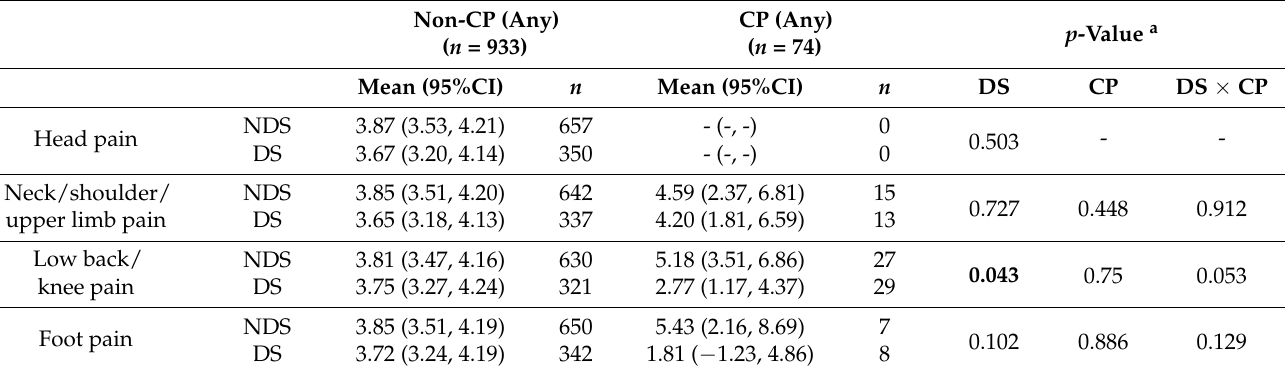
Table 4. Interactions between depressive symptoms and CP on alcohol intake (density method) in males. Non-CP (Any) ( n = 933)